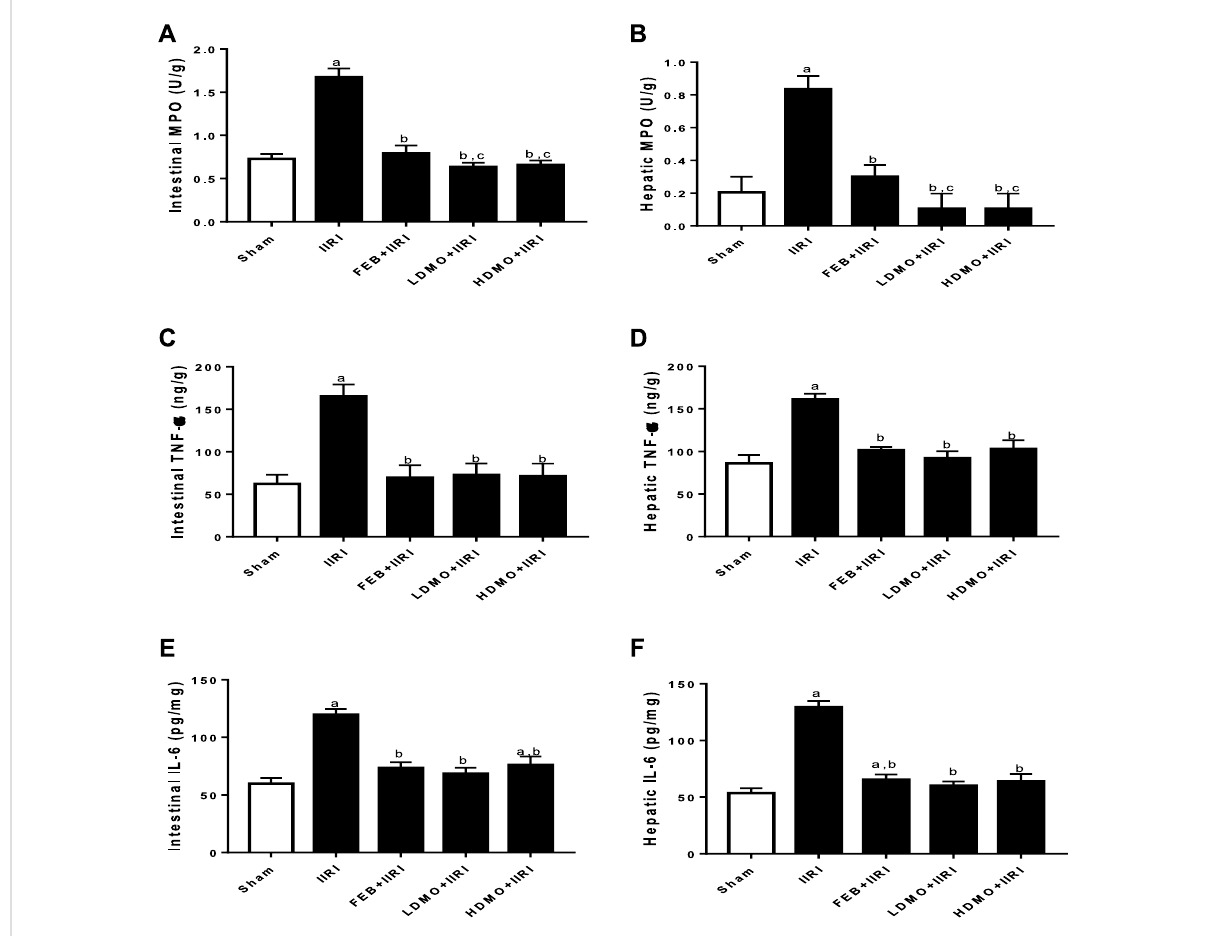
FIGURE 4 Effect of intestinal ischaemia/reperfusion (I/R) and methanolic Moringa oleifera leaf extract on markers of in fl ammation in the intestinal and hepatic tissues. MPO: Myeloperoxidase, TNF- α : tumour necrotic factor- α , IL-6: interleukin-6. IIRI: Intestinal ischaemia/reperfusion injury,